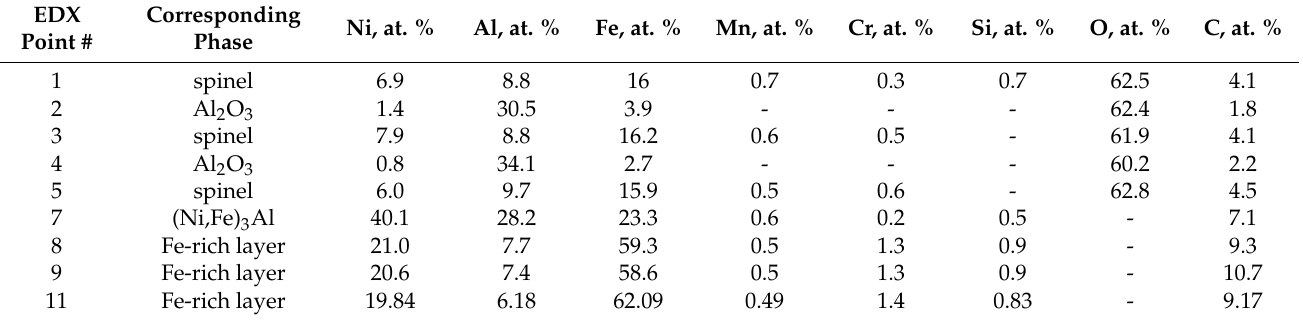
Figure 12. ( a , f ) EDX analysis of the oxide film of the NiAl-based coating after oxidation for 100 h at 1000 ◦ C (SEM image). The sample was prepared by Ar ion cutting at a 30-degree angle to the top surface; ( b – e ) EDX maps of element distribution for image in Figure ( a ); the composition of points indicated in Figure ( f ) is presented in Table 5. Table 5. EDX analysis in a 30-degree cut plane of the oxide scale formed at 1000 ◦ C (Figure 12f) (the values for the oxygen and carbon content are provided for